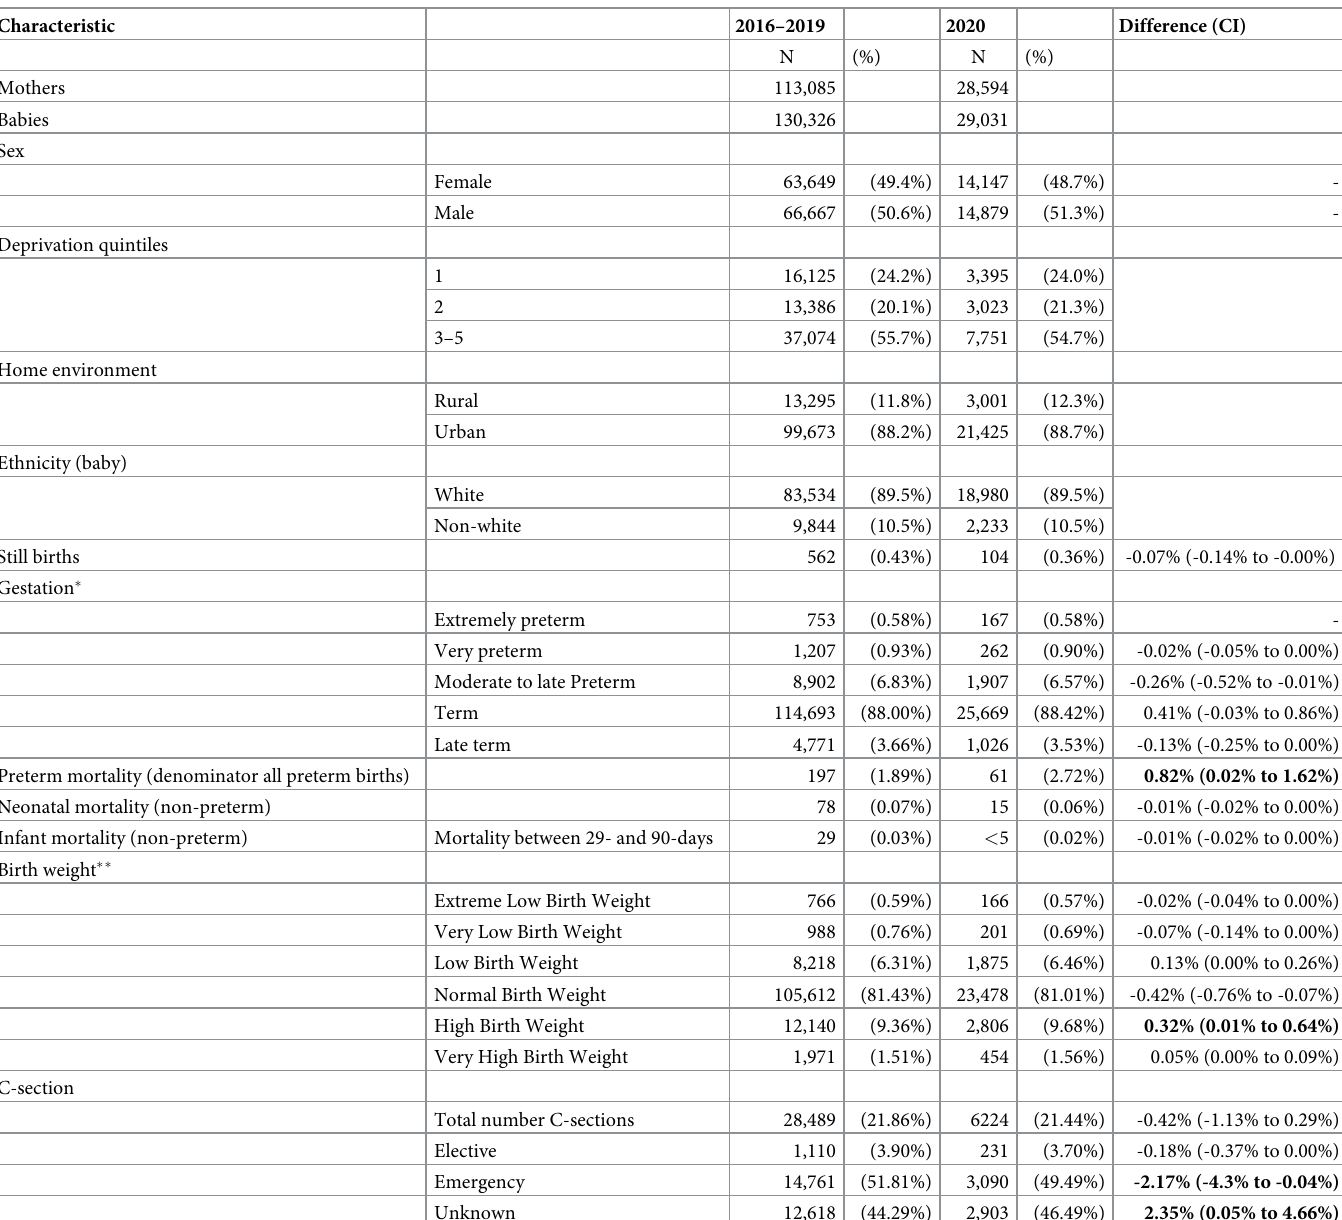
Table 4. Birth outcomes for infants born in 2020 compared to previous years.